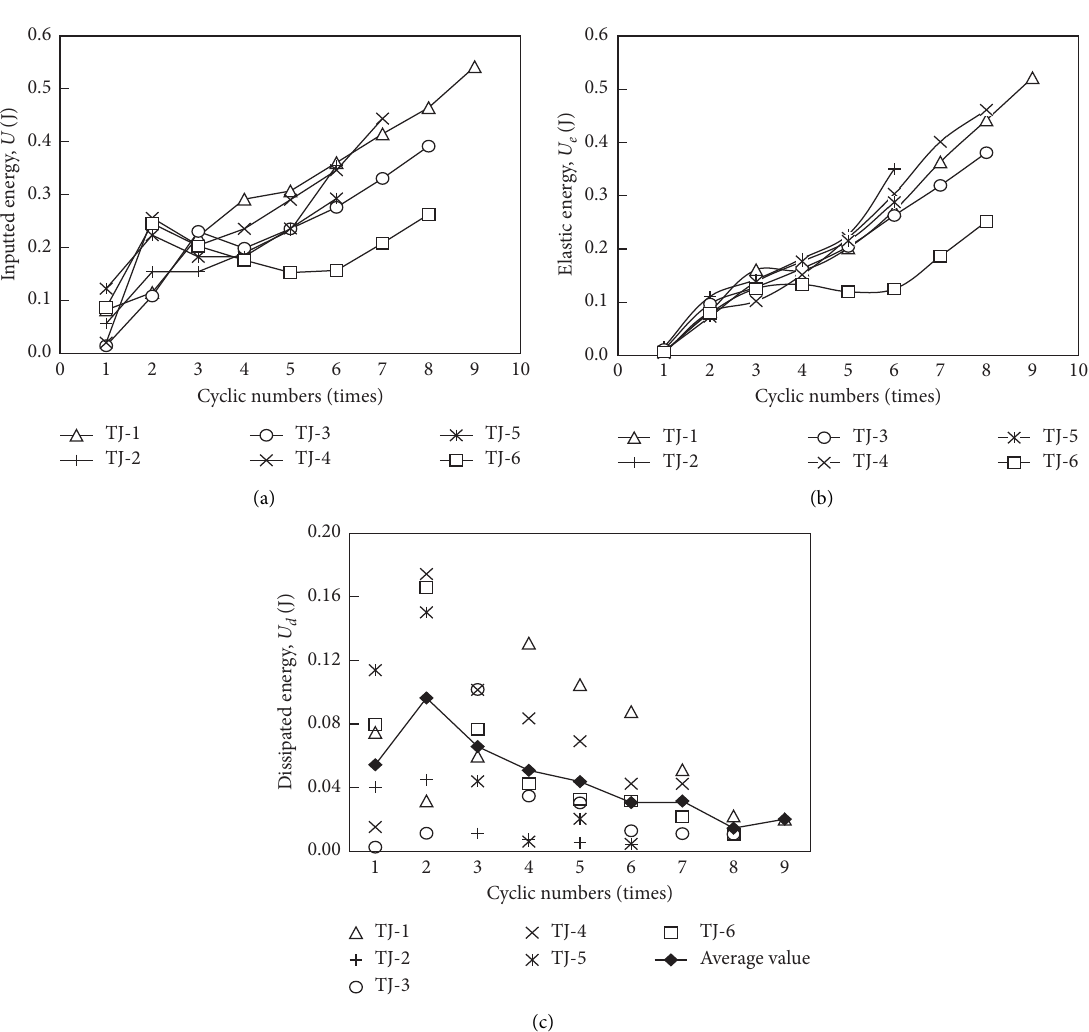
e . (c) Dissipated energy, U d